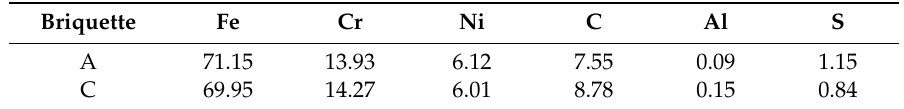
Table 2. Average compositions (SEM-EDS analysis) of the metals obtained from di ff erent briquettes after completion of the TGR experiments (in wt%).